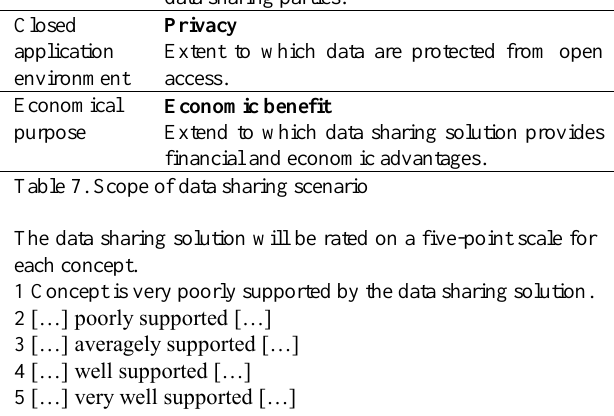
Figure 6. Crisis management ontology